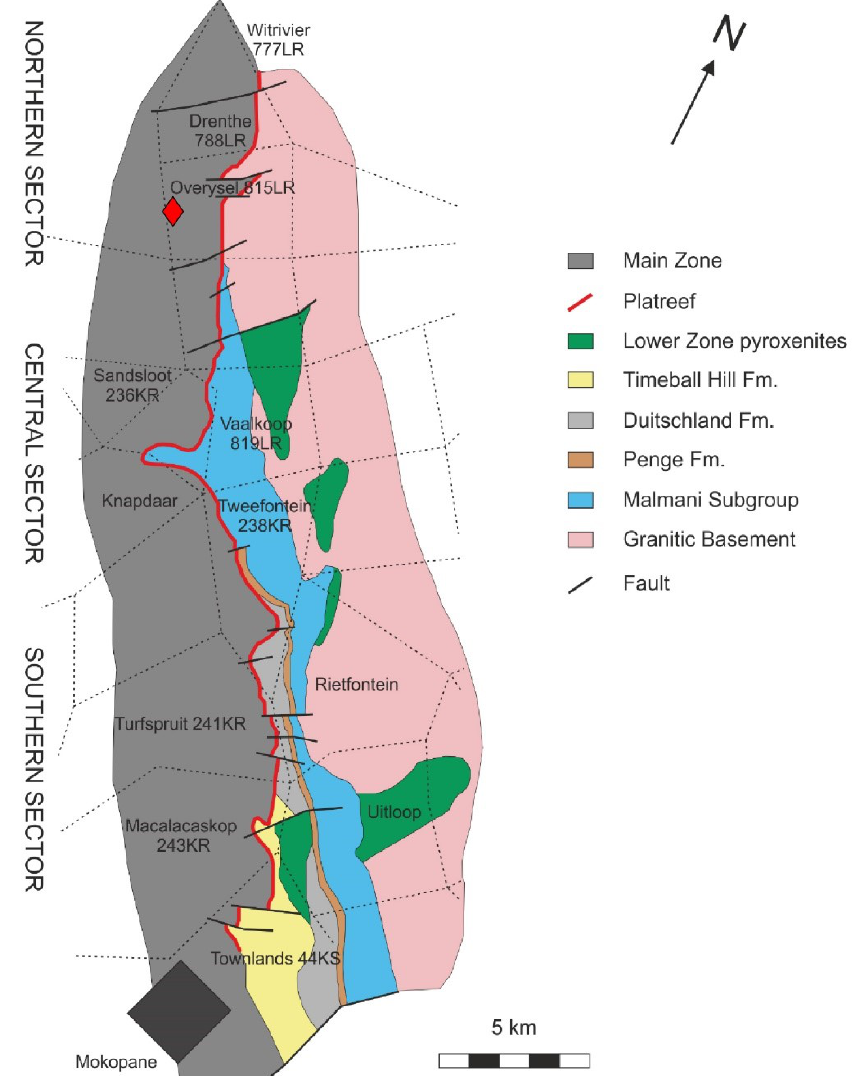
Figure 1. Geological map of the northern limb of the Bushveld Complex, showing the Platreef north of Mokopane modified after [61] . The borehole location (OY541) is indicated by the red diamond.